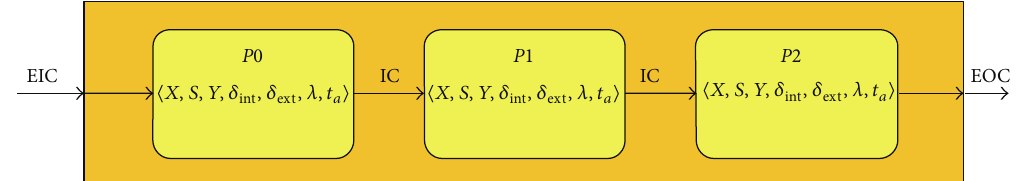
Figure 2: DEVS coupled model of a pipeline made by three processors in